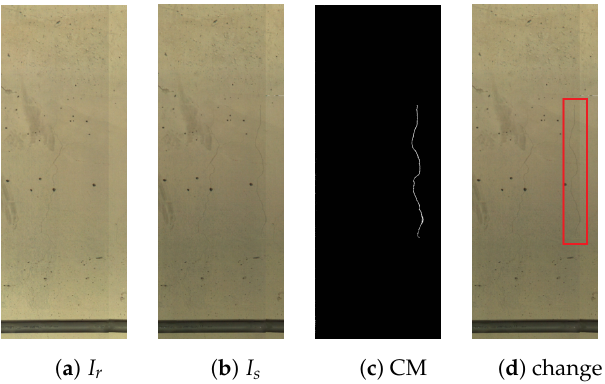
Figure 6. Change detection in an ideal-world scenario. I r ( a ), I s ( b ), CM ( c ) and change ( d